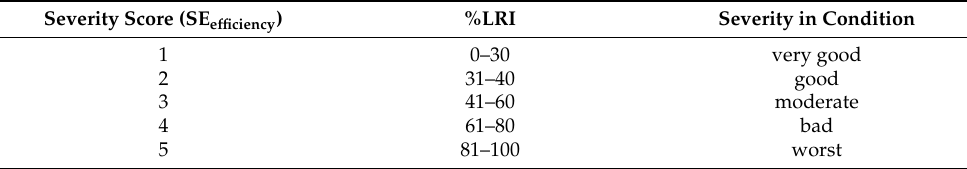
Table 4. %LRI interpretation as the severity score based on the efficiency